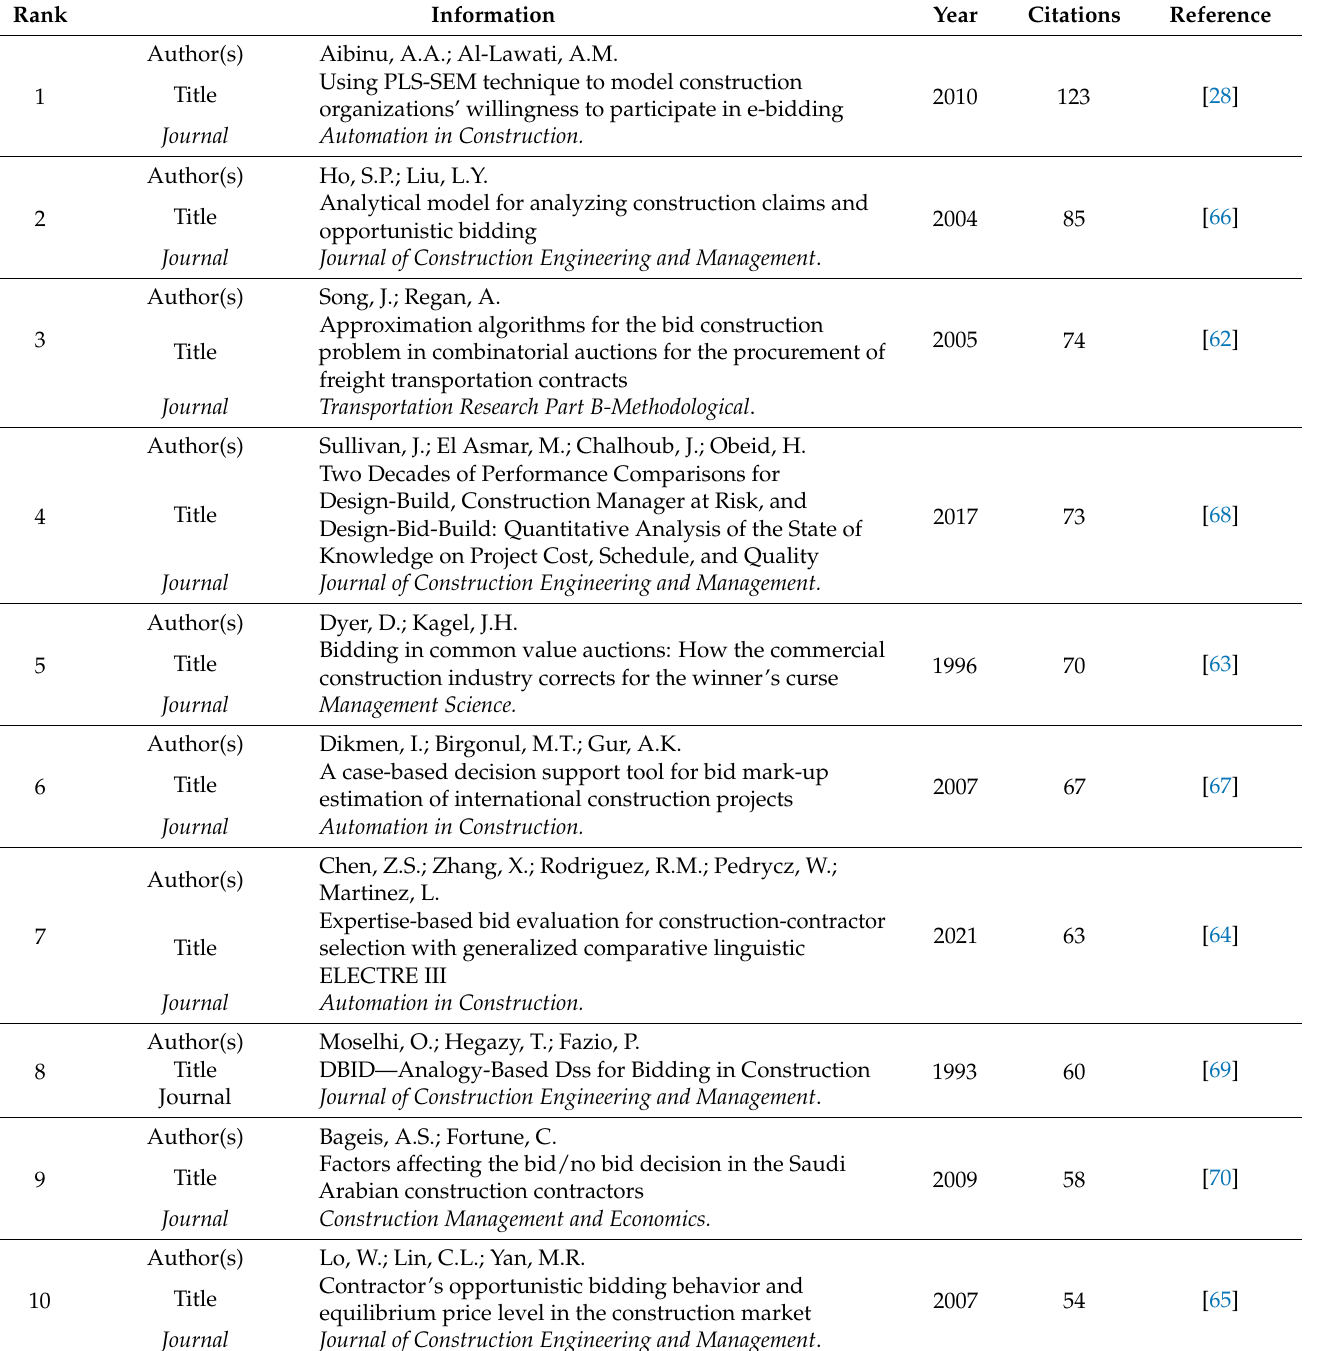
Table 2. Top 10 articles on construction bidding studies based on citation